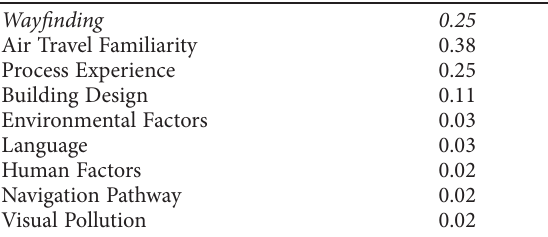
Table 5. Sensitivity analysis of the posterior network of the Wayfinding Bayesian Network (the output node, Wayfinding, is used as the reference point for the other